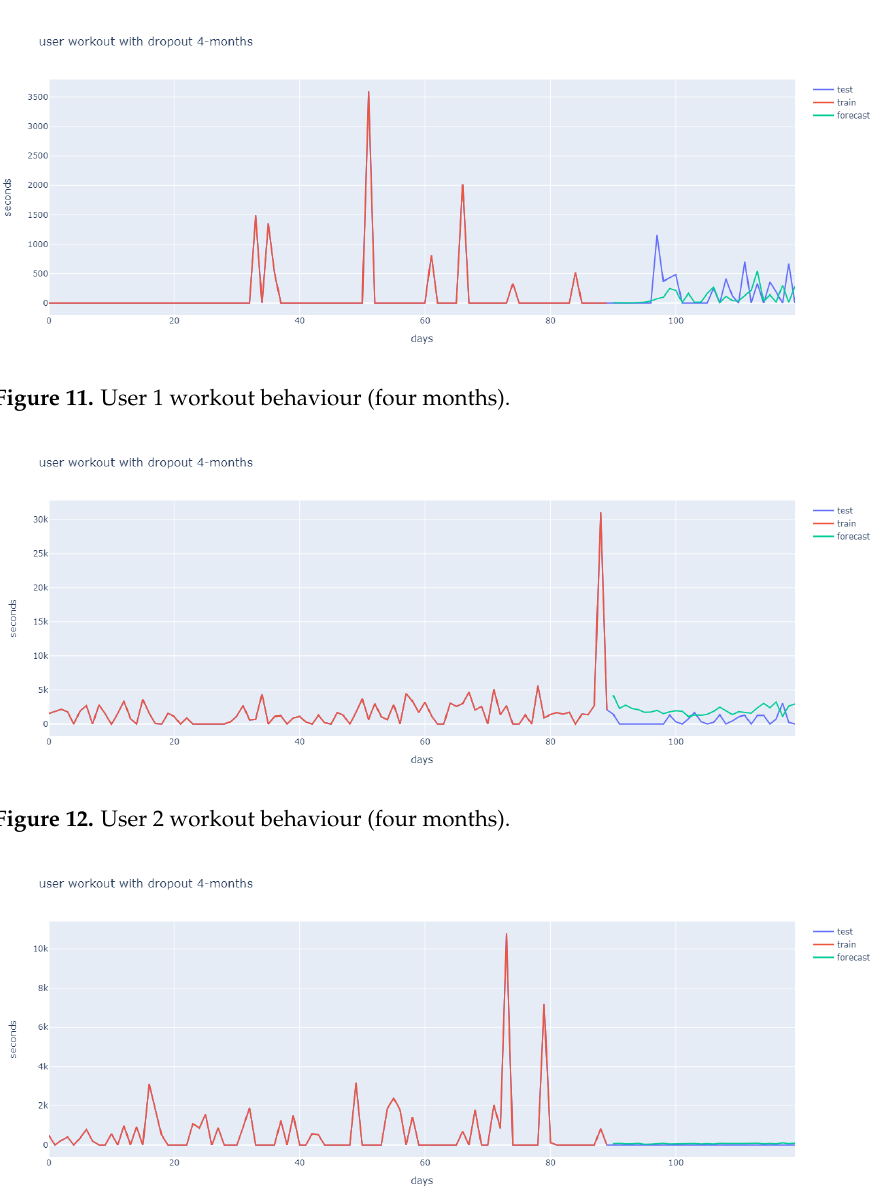
Figure 13. User 3 workout behaviour (four